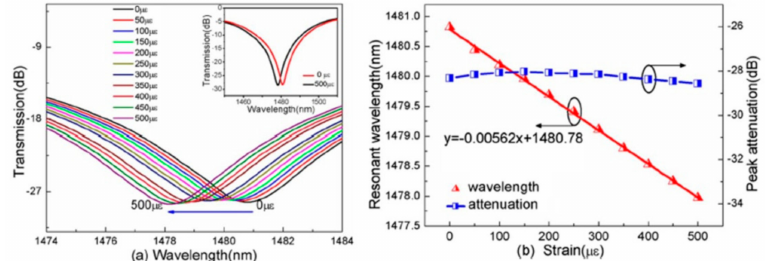
Figure 34. ( a ) Transmission spectrum evolution of the strain sensor based on ILPFG with a sensitivity of –5.62 pm / µε ; ( b ) measured resonant wavelength and peak attenuation as a function of the strain